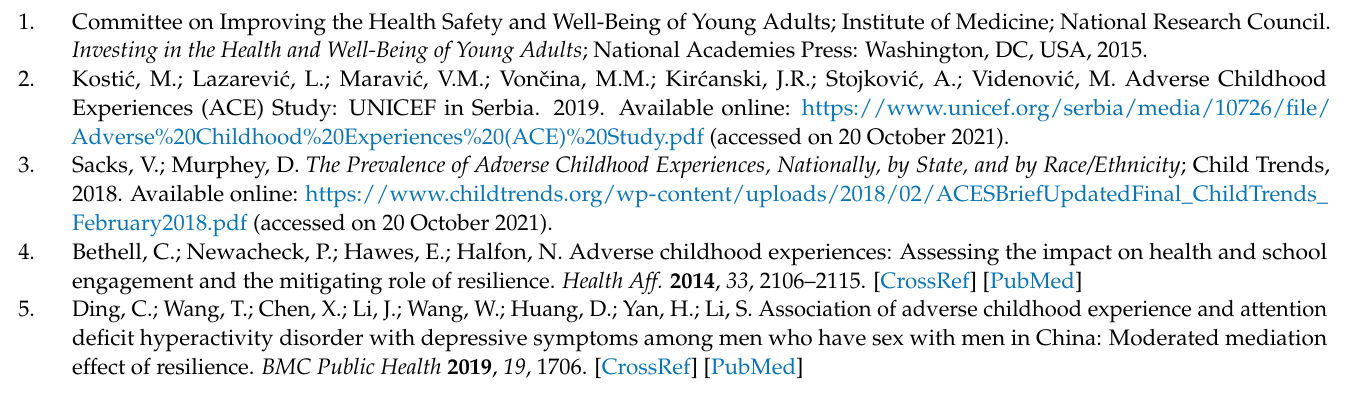
the correlation between ACEs and resilience. Figure S2: Funnel plot showing high publication bias in the meta-analysis of the association between ACEs and resilience using dichotomous